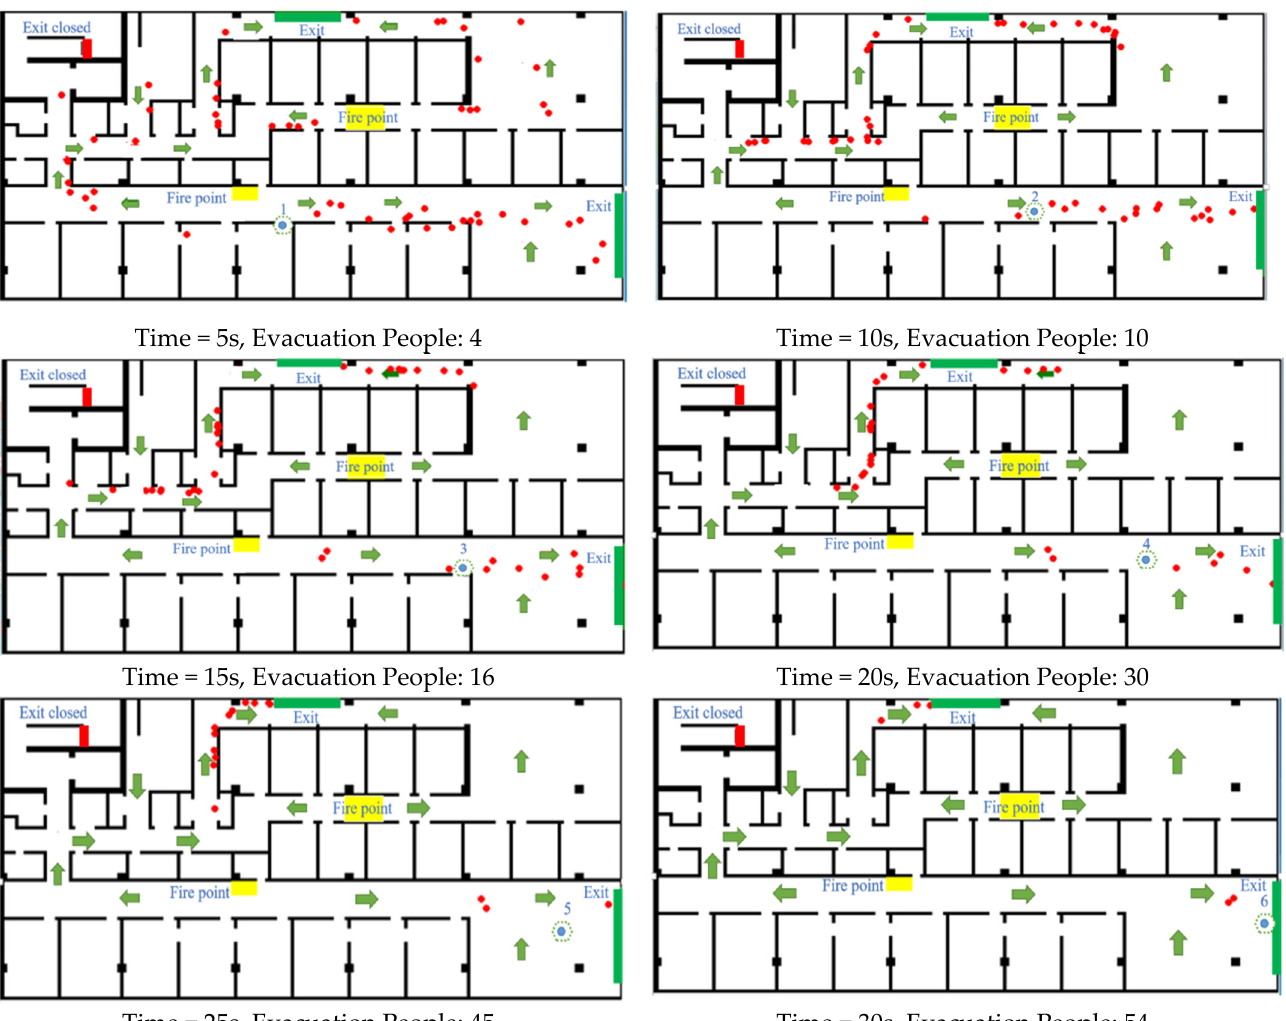
Figure 11. Dynamic steps of the personnel escape process.